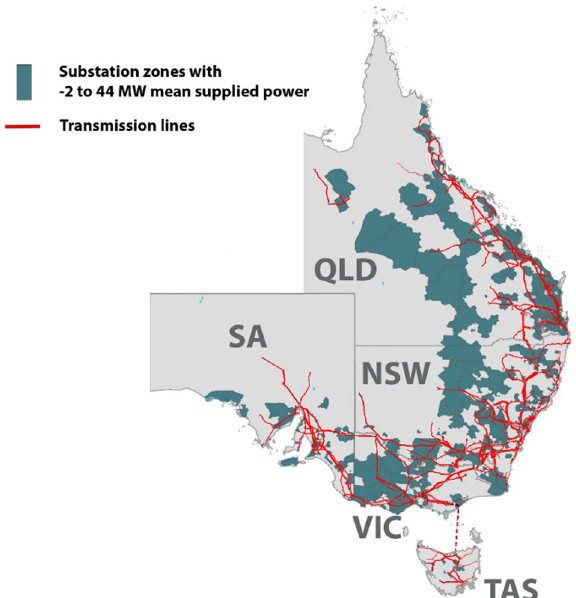
Fig. 2 NEM regions, major electricity transmission lines and substation zones (data provided by National Map